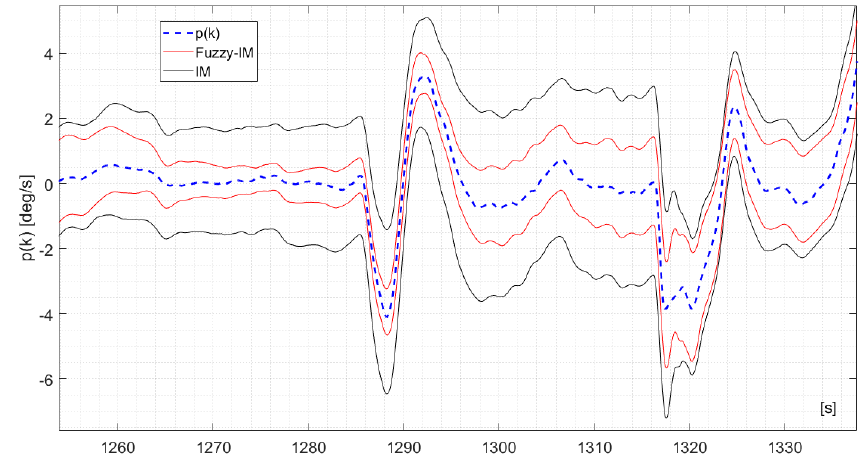
Figure 4. The measured p ( k ) signal and the time varying upper bounds p ( k ) and lower bounds p ( k ) derived for the IM applying Equation (18) and for the FIM applying Equation (20).